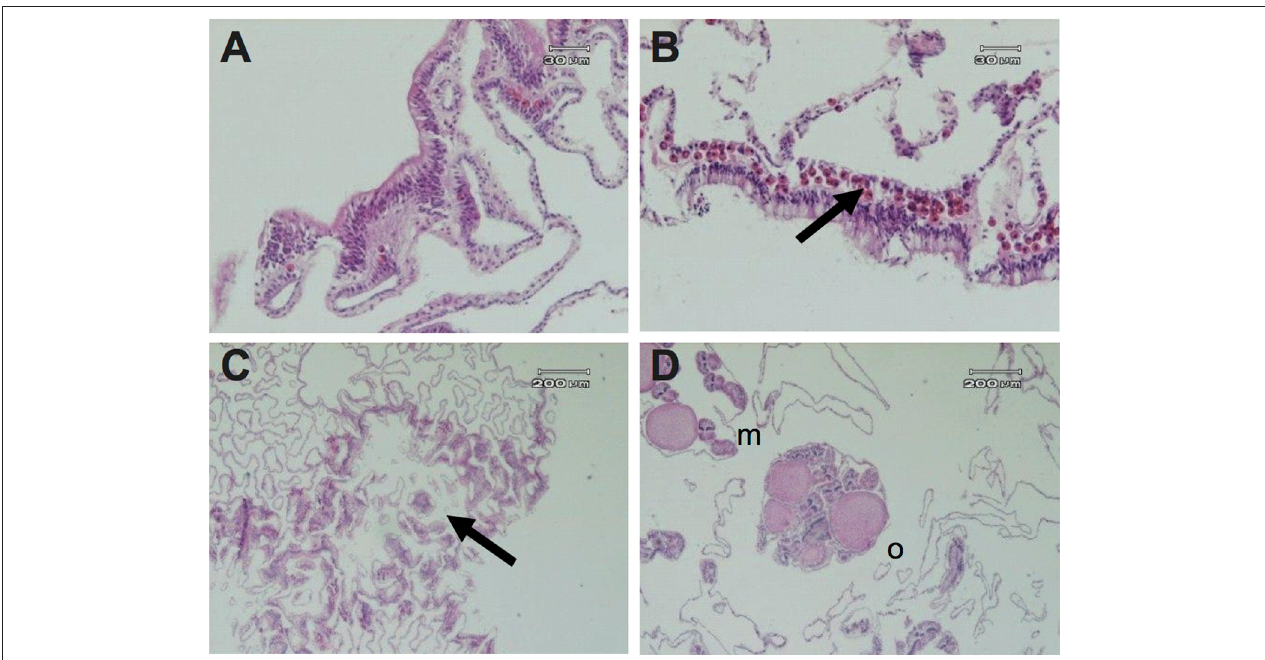
FIGURE 3 | Histological micrographs of A. muricata tissues depicting: (A) absence of Symbiodinium cells in the gastrodermis of a colony with a growth anomaly; (B) presence of Symbiodinium cells in the gastrodermis of a healthy colony; (C) deficiency of polyp structure (arrow) and chaotic arrangement of gastrovascular canals in GA tissue; (D) healthy tissue with eggs (o) and mesenteries (m) in a colony with a